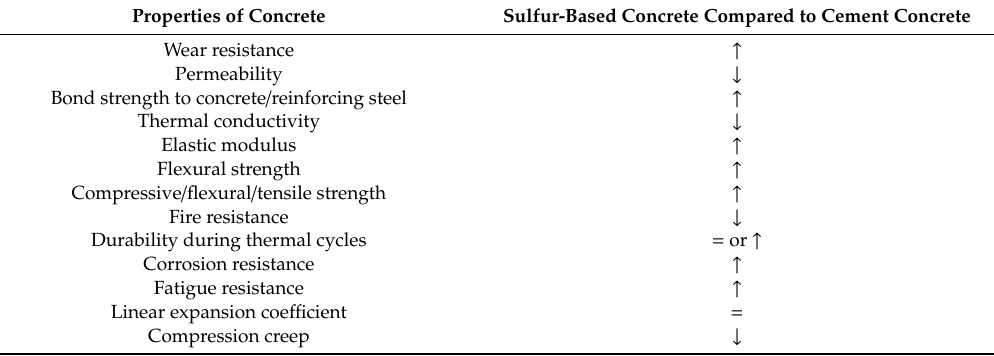
Figure 9. New and existing market of sulfur worldwide (data extracted from Reference [36]). Table 4. Comparison of sulfur and cement concrete ( ↑ : High, ↓ : Low and = : equivalent)